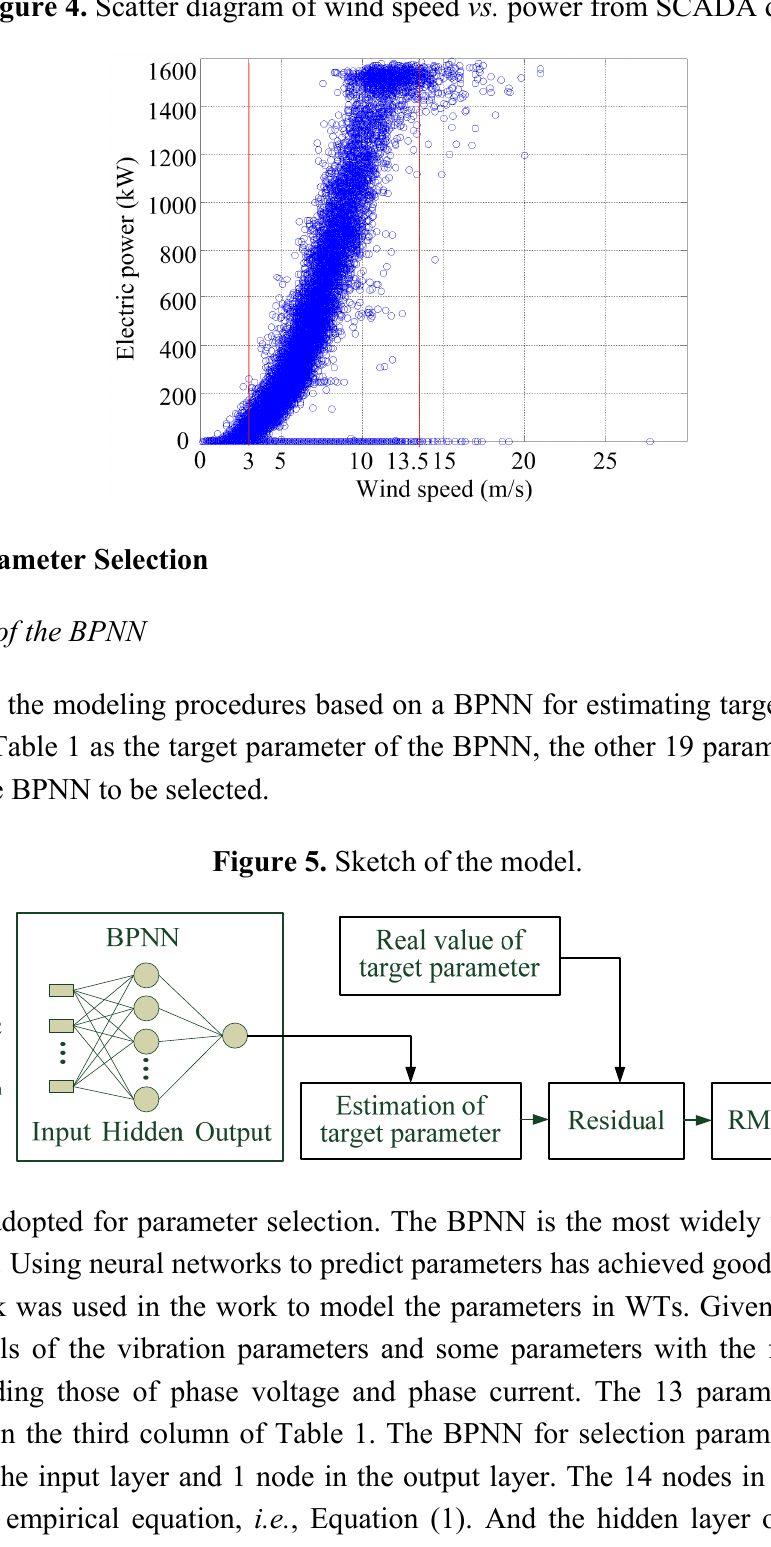
Figure 4. Scatter diagram of wind speed vs. power from SCADA data.